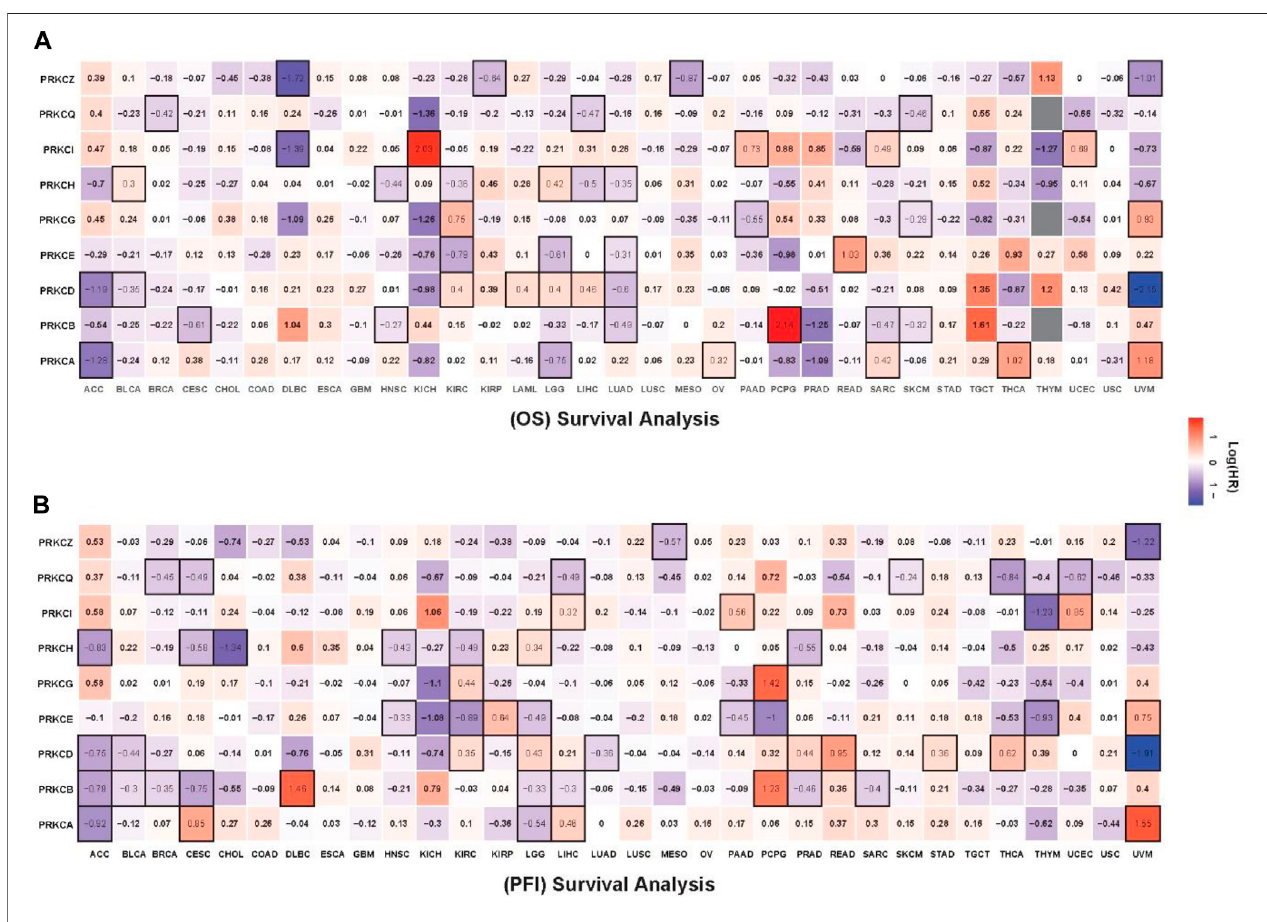
FIGURE 5 | Survival heatmap for OS (A) , PFI (B) analysis comparing the HR of high expressing group versus low expressing group for all PKC genes in the TCGA tumors.TheredcolorindicatesHRforthehigh-expressinggroup;thebluecolorindicatestheHRforthelow-expressinggroup;theblackborderreferstothestatistically log-rank test ( p -value <